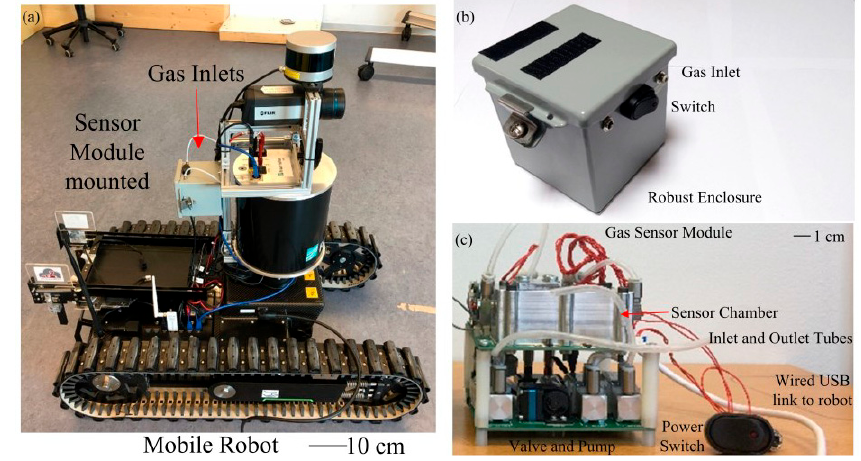
Figure 1. Photographs showing robust gas sensor module, ( a ) module installed on tracked exploration robot, ( b ) steel enclosure holding sensor module with inlet for gas sampling, ( c ) internal components of sensor module, stack PCB design, upper board contains low power sensor components, lower board contains flow control circuitry (pump and